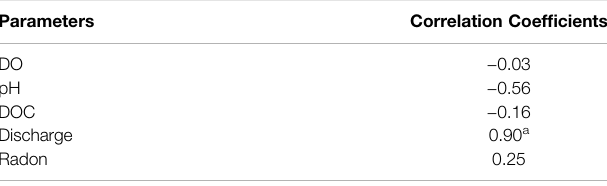
TABLE 2 | The values of Pearson correlation coef fi cient (r) of pCO 2 with water quality variables at site G of the headwater stream.